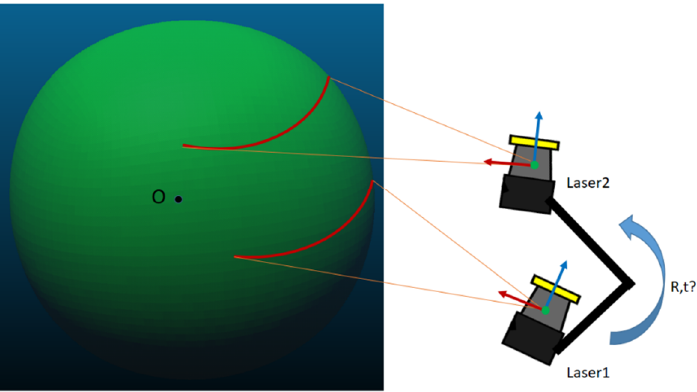
Figure 1. Observation of a sphere by a combination of two laser rangefinders (LRFs). The red scans reflected by the sphere are from the different LRF body frames, and the spherical center O is the common point for establishing the corresponding points (CPs). Assuming that the Laser1 body frame is a global reference frame, the transformation parameters ( R, t ) between the two LRF body frames can be solved by extrinsic calibration.